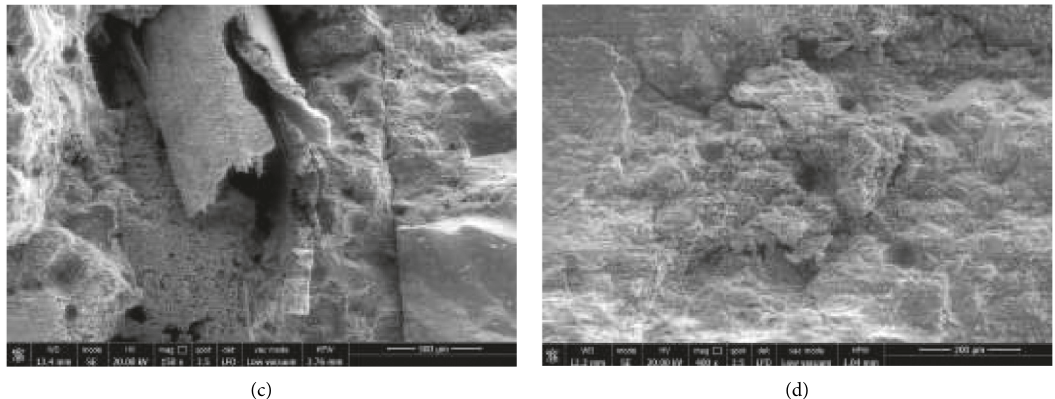
Figure 3: Scanning electron microscope photos. (a) Surface of unmodified pasture fibre. (b) Surface of modified pasture fibre. (c) The tensile failure state of the pasture fibre. (d) The microphysical state of rubber powder.